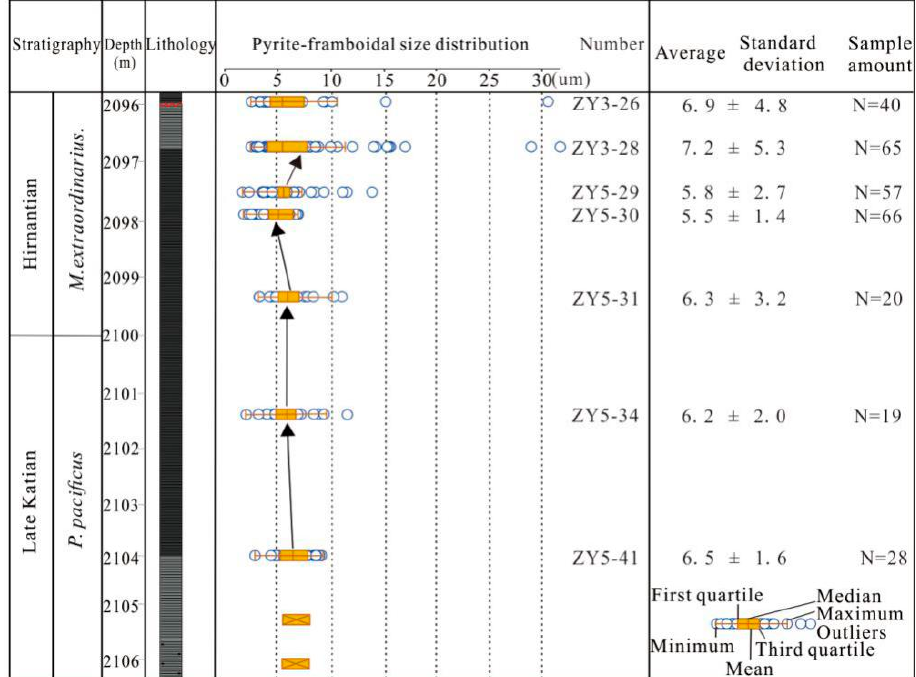
Figure 5. Morphological characteristics of pyrite in the shale samples of Well ZY5: ( a ) euhedral pyrite aggregate, sample of P. pacificus zone; ( b , c ) Pyritohedral microcrystals in tiny framboidal pyrite, sample of M. extraordinarius zone.